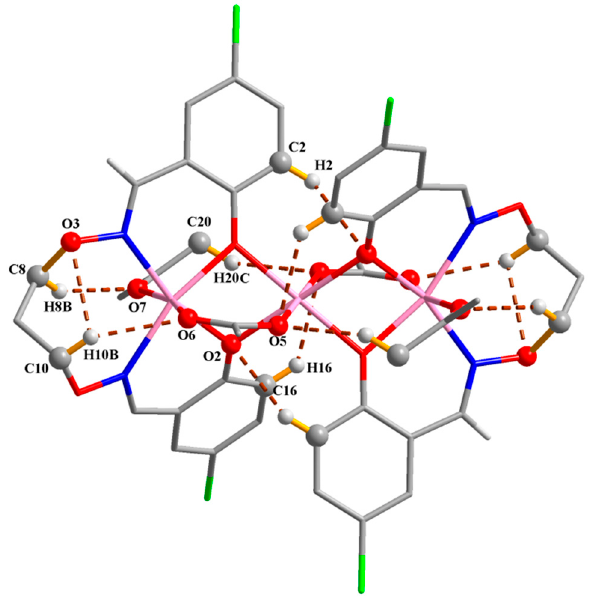
Figure 4. View of the intra-molecular hydrogen bonds of coordination compound 1 . Crystals 2018 , 8 , 43